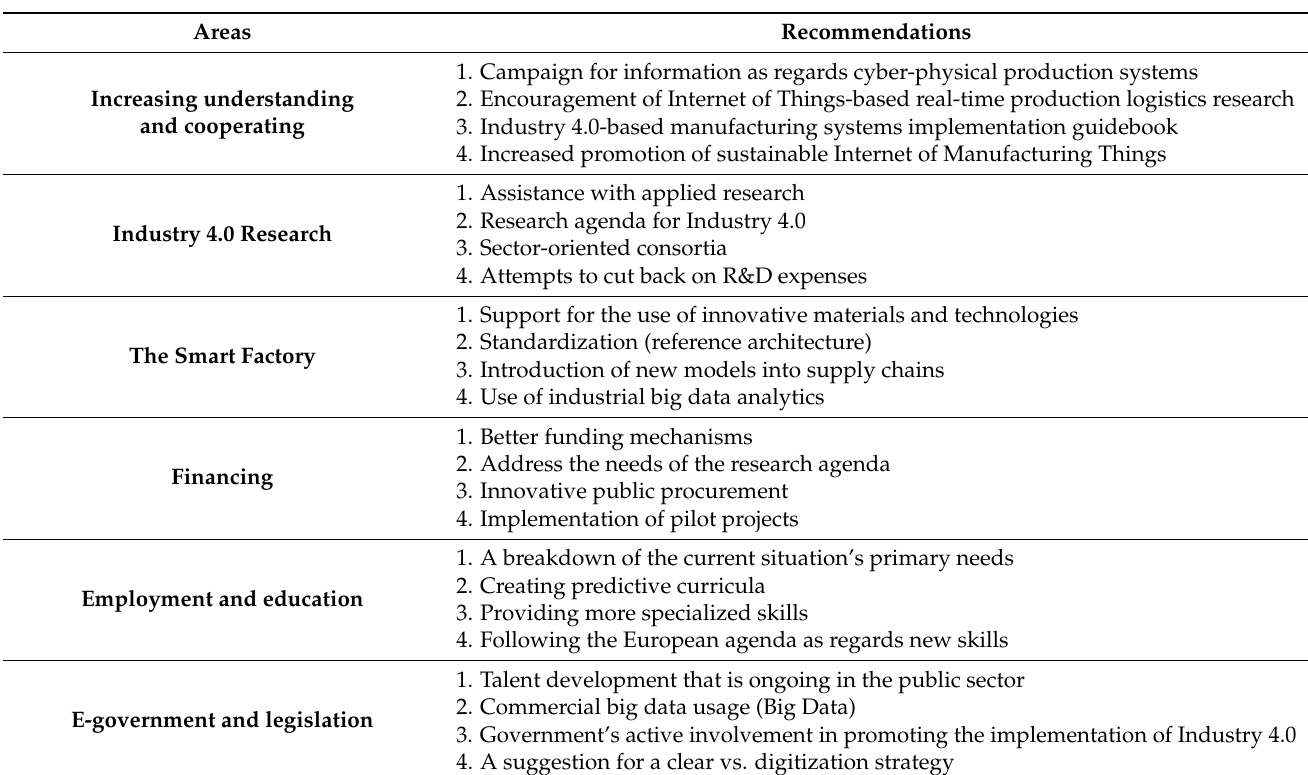
Table 3. A thorough list of suggestions for the Slovak